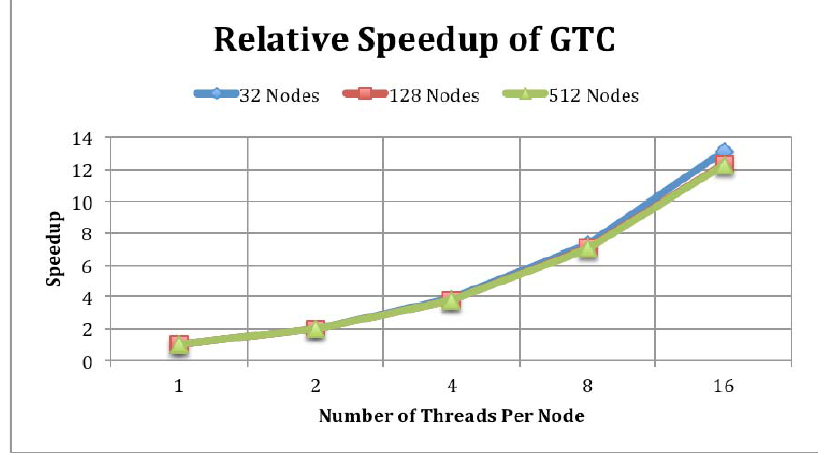
Figure 12. Performance comparison of GTC with different number of threads per node